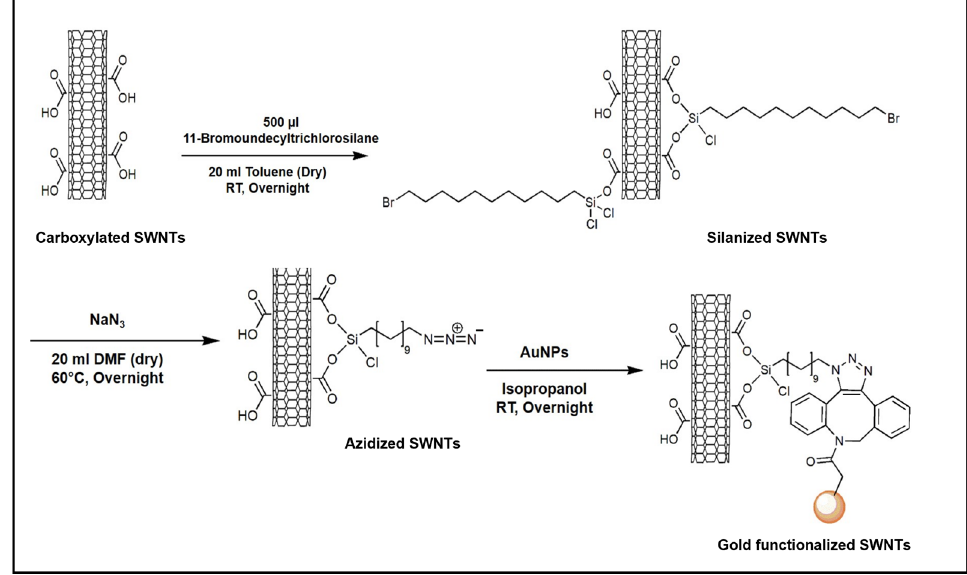
Figure 1. Schematic of all steps of the SWNT functionalization with AuNPs-DBCO. The carboxylated SWNTs are silanized. DBCO is grafted to the azidized silane using SPAAC.